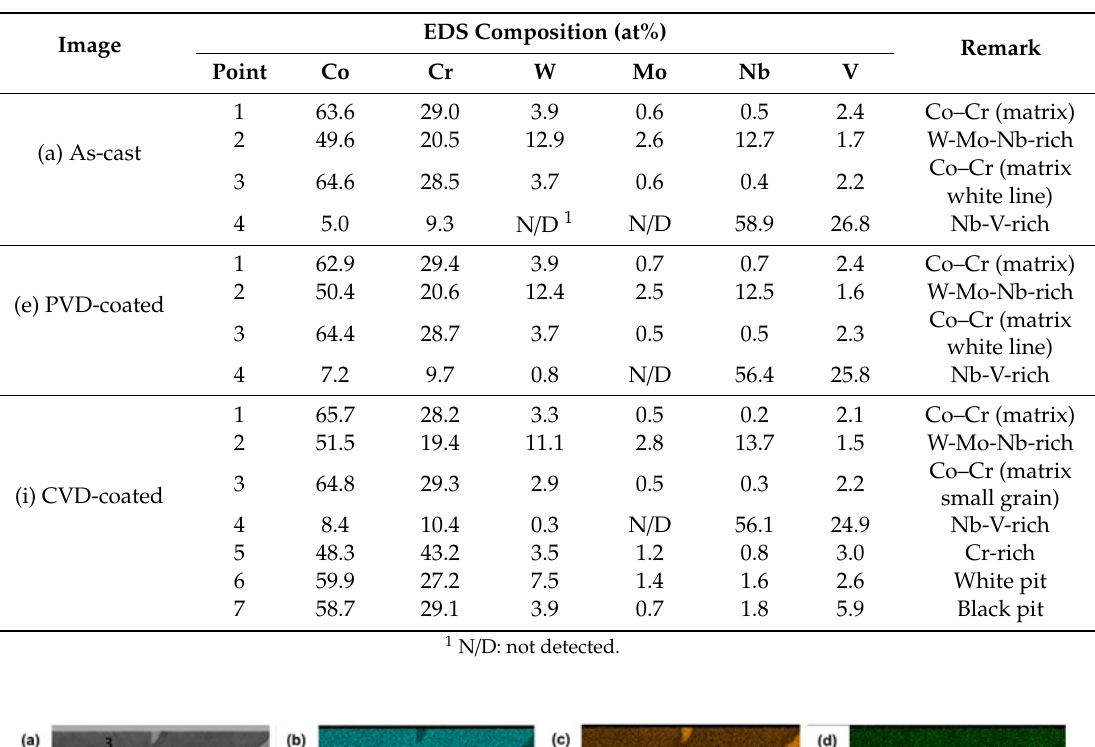
Table 2. Results of the EDS spot analysis showing the atomic weight (at%) composition ratios for the points marked in images (a), (e), and (i) of Figure 7.